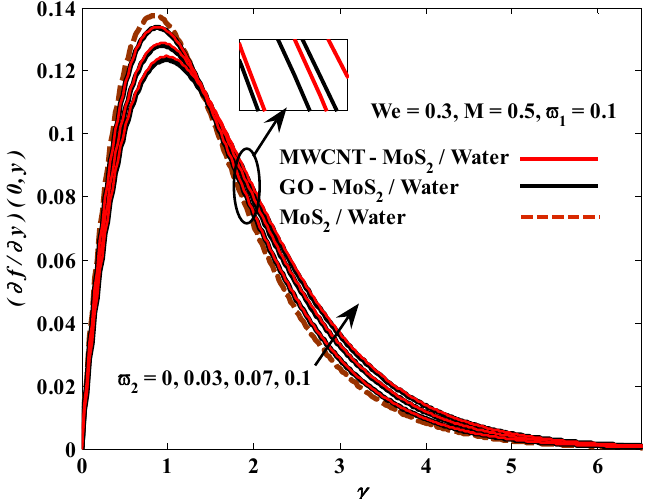
Figure 14. The behavior of hybrid nanofluid’s velocity under the effect of ultrafine particle volume fraction .